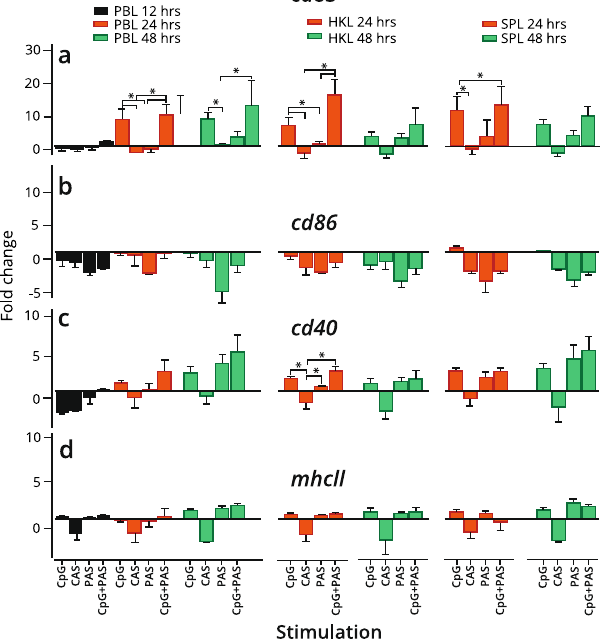
Figure 5. Expression of APC marker and co-stimulatory genes in IgM + B cells treated with CpG and/or condition supernatants. IgM + B cells from Atlantic salmon peripheral blood (PB), head kidney (HK) and spleen leukocytes were MACS purified, stimulated in vitro or left untreated and analyzed by RT-qPCR for expression of ( a ) cd83 , ( b ) cd86 , ( c ) cd40 and ( d ) mhcII . Gene expression data at each time point were normalized against the endogenous control gene EF1aB and fold changes were calculated using the unstimulated sample at the same time point 74 . Data represent mean ± s.e.m from at least three individuals (n = 3 to 6). The line intersecting the y-axis at 1 represents the unstimulated control that the fold change of the treatments are in relation to. Significant fold changes (p < 0.05) are indicated by * . CAS; Control adherent cell supernatant, PAS; Pulse adherent cell